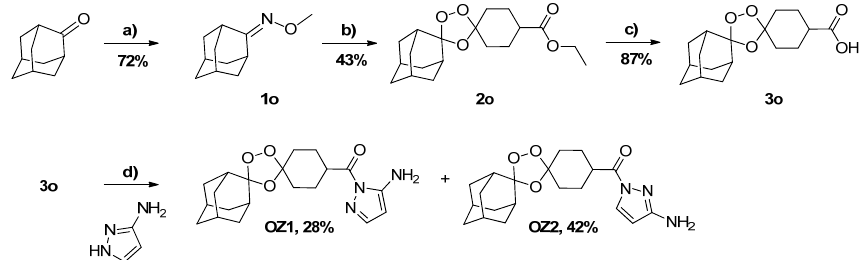
Figure 1. Structures of: ( A ) 1,2,4 ‐ trioxolane LC95 [5], 1,2,4,5 ‐ tetraoxane LC140 [1], and pyrazole derivative 3i [17], with known antileishmanial activity; and ( B ) 1,2,4 ‐ trioxolane ‐ 3(5)